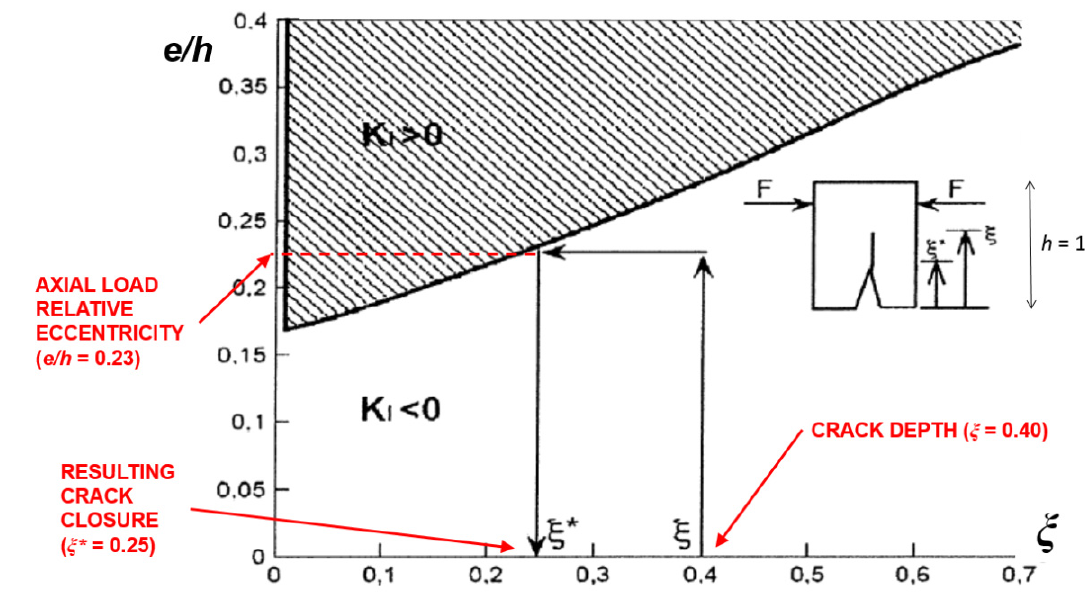
Figure 5. Crack closing condition for off-center compression (arch-structure crack closure): case of an arch cross-section with a crack depth equal to ξ = 0.40, and subjected to an off-center compression with e / h = 0.23, which returns a crack closure corresponding to ξ * = 0.25.